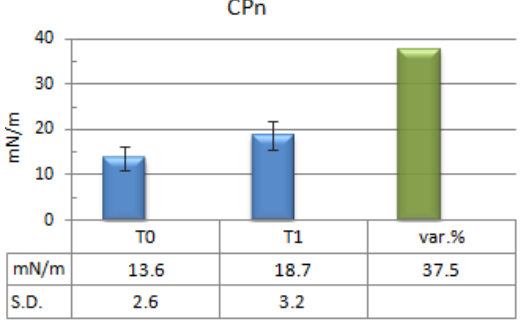
Figure 5. Surface energy changes in adult skin after treatment with Camianta protocol.